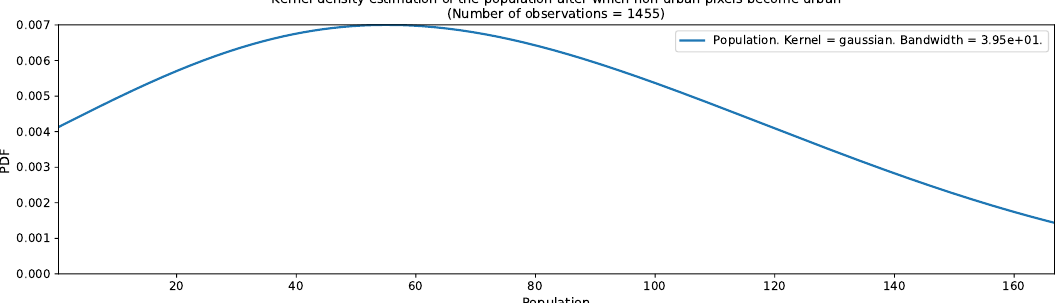
Figure 16. Estimated probability density function of a population threshold after which a non-urban pixel becomes urban in Valledupar.